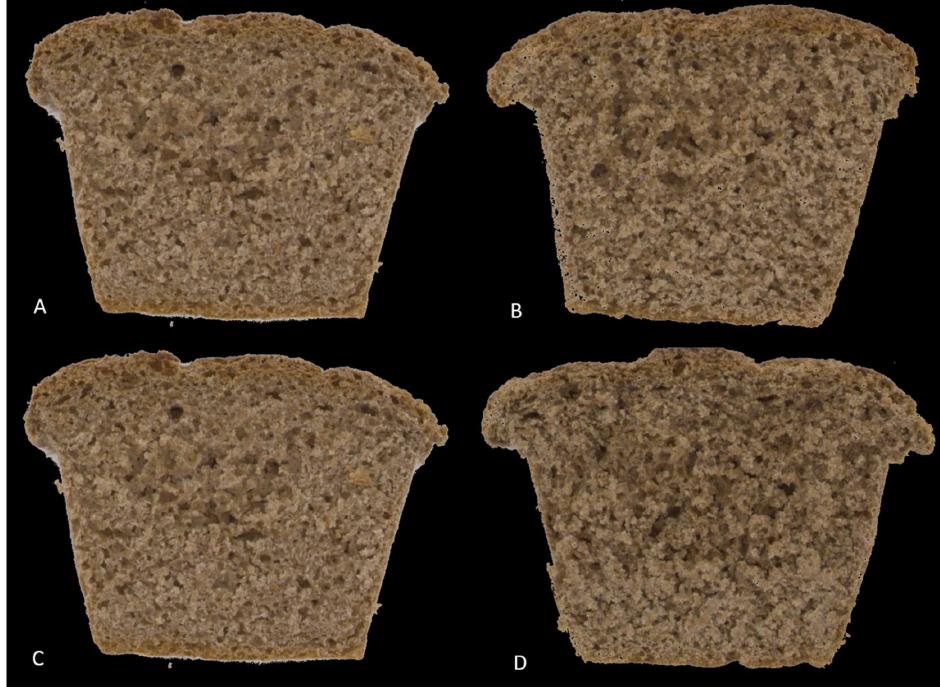
Figure 2. Picture of bread loaves. ( A) control sample—100% wheat flour, ( B) mealworm powder 5%, ( C) mealworm powder 10%, ( D) mealworm powder 15%. The color, texture, and volume of bakery products influence consumer choice and acceptance. The values of CIE L*a*b* coordinates, the density of bread loaf, water activity, and hardness are presented in Table 3. The tested preparations differed statistically significantly ( p < 0.05) in L*, a*, b*, browning index, and hardness. Table 3. Physicochemical properties of obtained breads loaves.